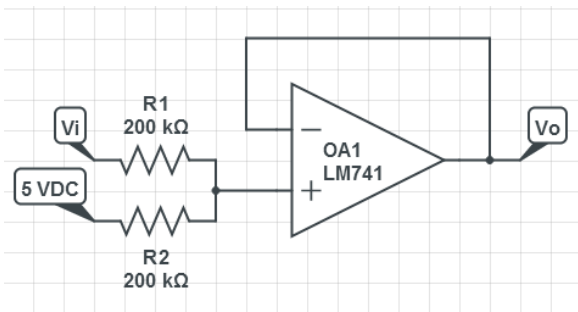
Figure 12. Signal conditioning circuit between tachometer and